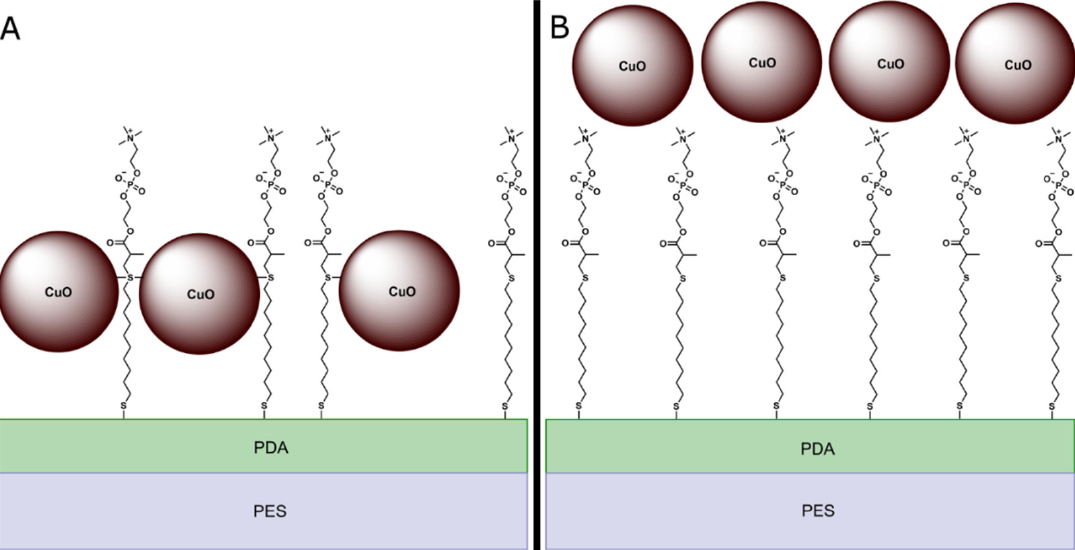
Figure 2. Possible structures of functionalized membrane top layer. In structure ( A ), CuO NPs are covalently bonded to the central sulfur atoms in MPC-SH. In structure ( B ), CuO NPs are adsorbed on top of the MPC-SH.